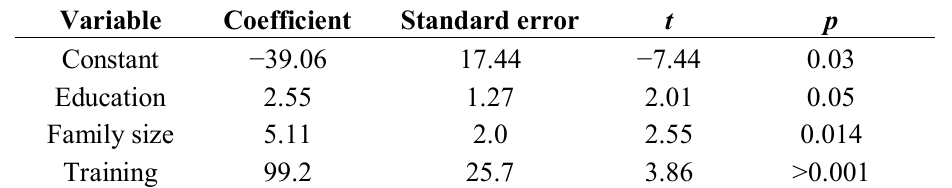
Table 4. Factors significantly affecting bamboo commercialization in Sheka ( R ² = 0.29, p <